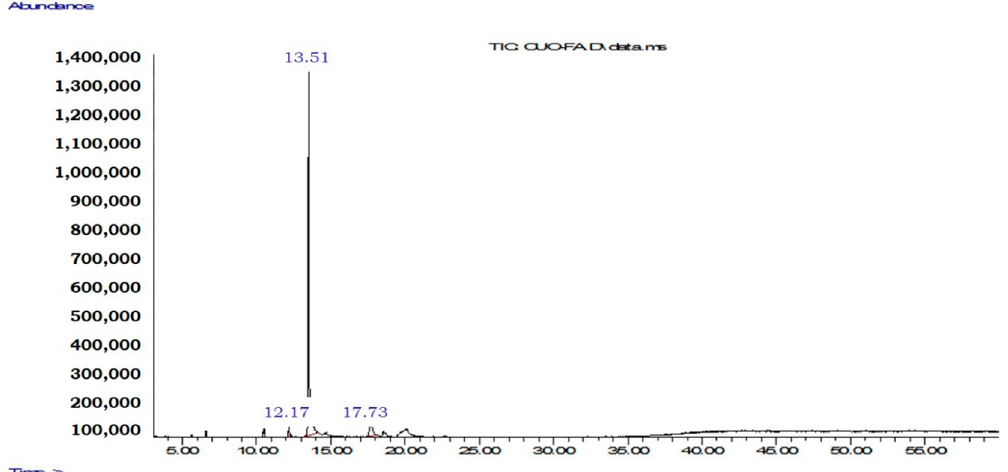
Molecules 2022 , 27 , x FOR PEER REVIEW Figure A9. Dipteryx odorata seeds extract chromatogram. Figure A9. Dipteryx odorata seeds extract chromatogram.